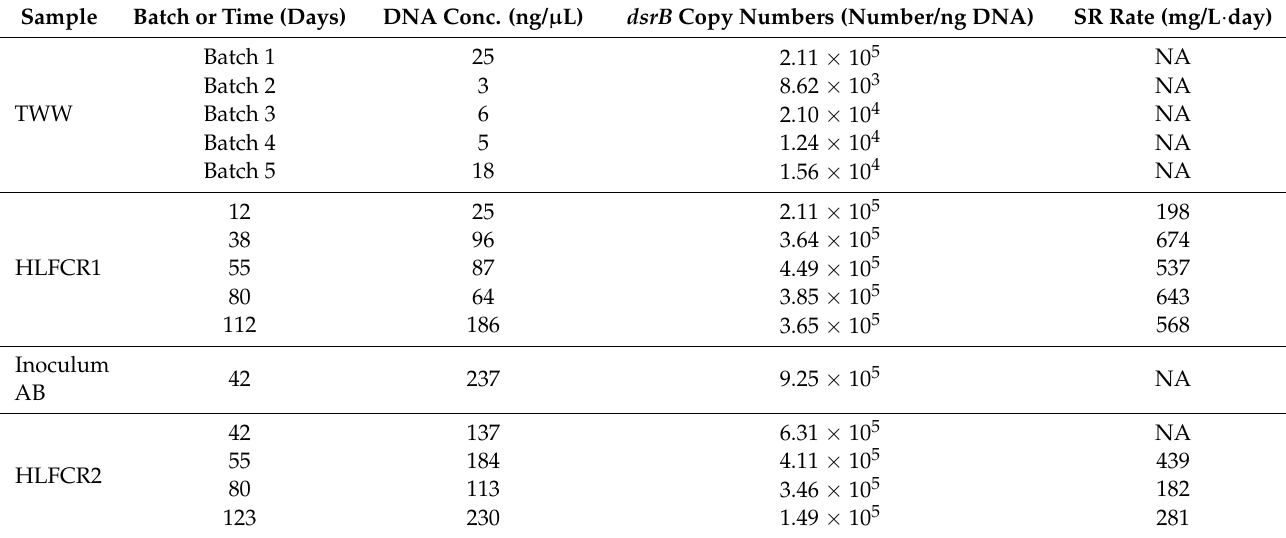
Table 4. Comparison of functional ( dsrB ) gene abundance and sulfate reduction